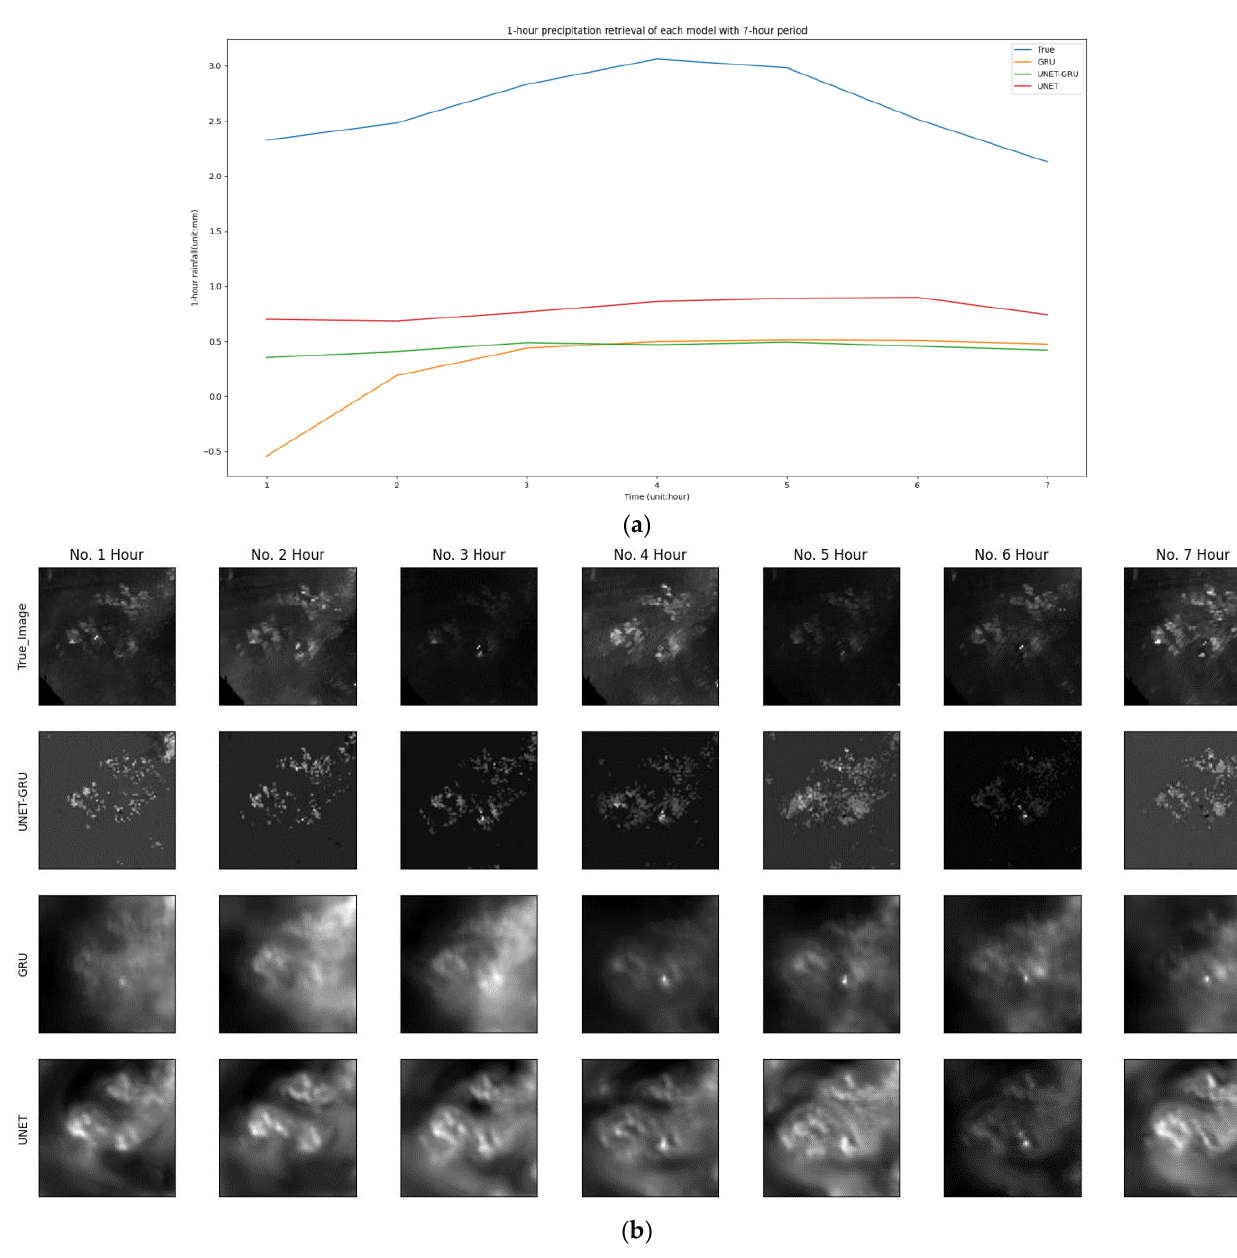
Figure 9. Comparison of 7-h grid and average rainfall inversion for a simulated artificial rainfall event in Wuhan region. ( a ) Comparison chart of 1-h rainfall forecast and actual measurement values for each model (lasts for 7 h). ( b ) Comparison of 1-h grid-based rainfall forecasts and observed values from different models (lasts for 7 h). Table 5. Effect estimates of artificial precipitation compared with historical